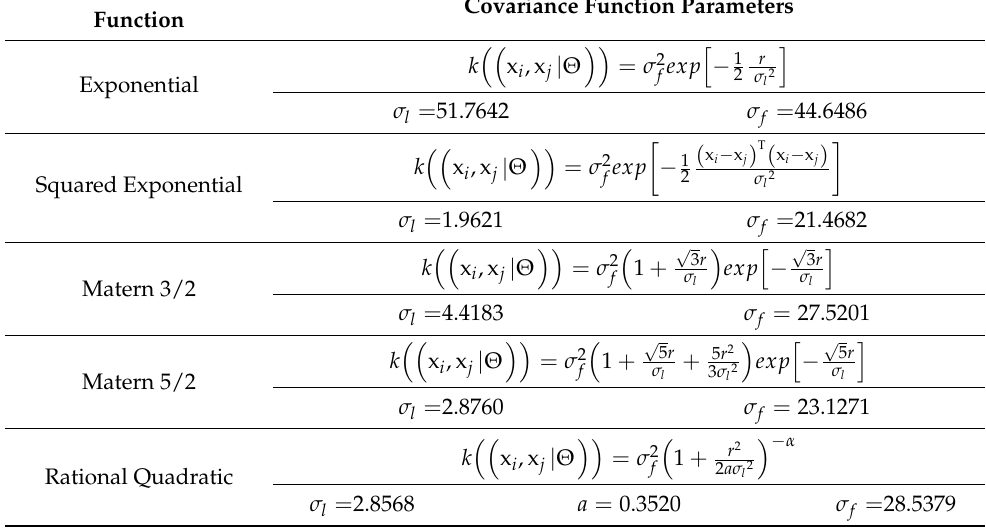
Table 7. Parameters of GPR ARD model covariance functions.